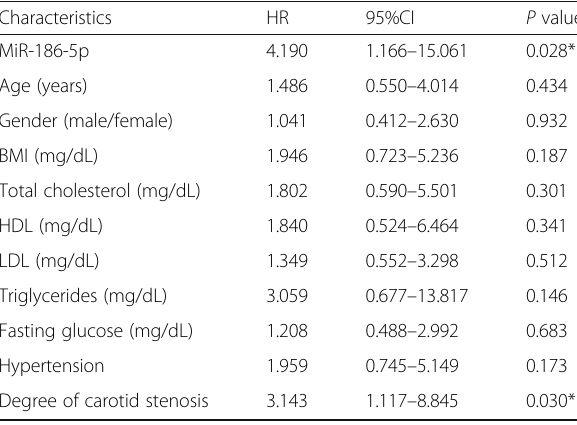
Table 4 Multivariate Cox regression analysis for miR-186b-5p in patients with asymptomatic